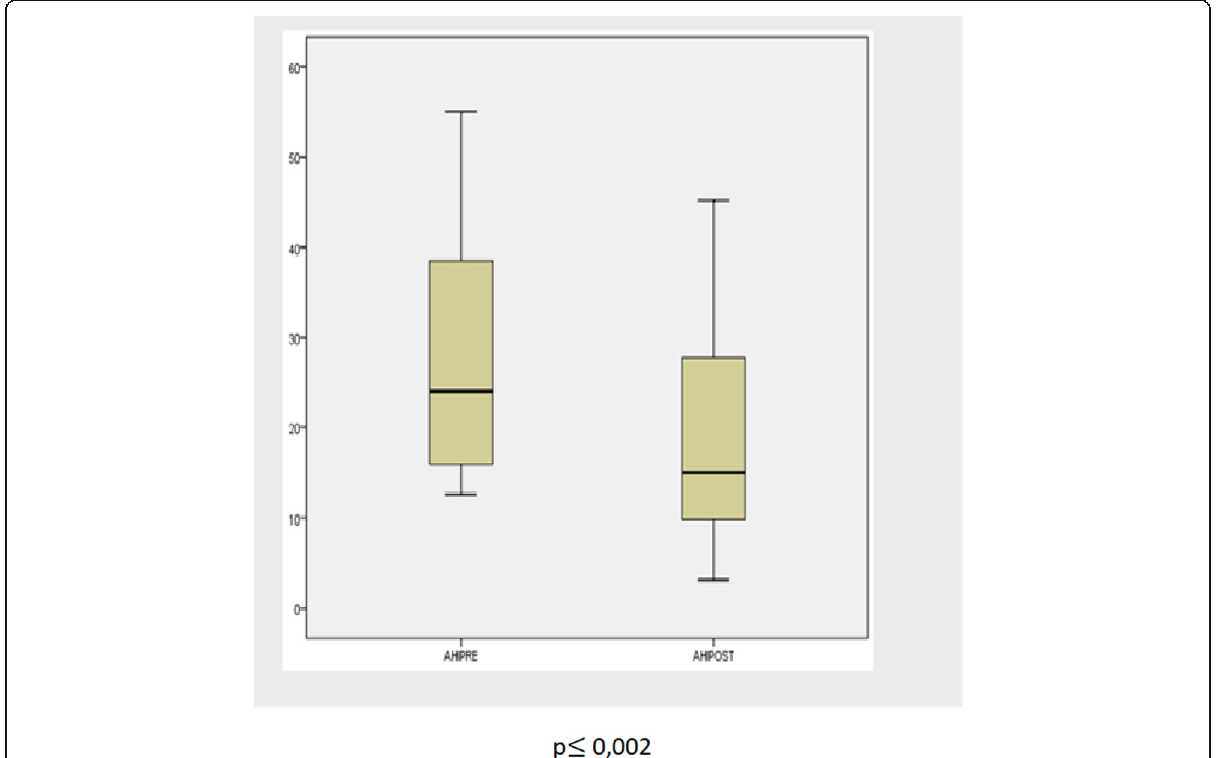
Fig. 5 Box plot showing statistical significant differences between study and control